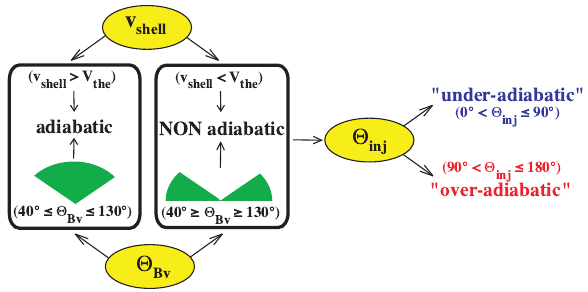
Fig. 10. Synoptic of the three key parameters (yellow disks) in- volve in the adiabatic/nonadiabatic behavior classification. The pitch angle θ Bv defined approximately two different behaviors, −→ B , −→ v ) plane: (i) as illustrated by the green portion of the ( for 40 ◦ ≤ θ Bv ≤ 130 ◦ , individual µ are conserved while (ii) for 40 ◦ ≥ θ Bv , θ Bv ≥ 130 ◦ , they are nonconserved. Among transmit- ted nonadiabatic electrons, injection angle θ inj clearly separates the “under-” and the “over-adiabatic” behavior which appears un- der and over 90 ◦ ,